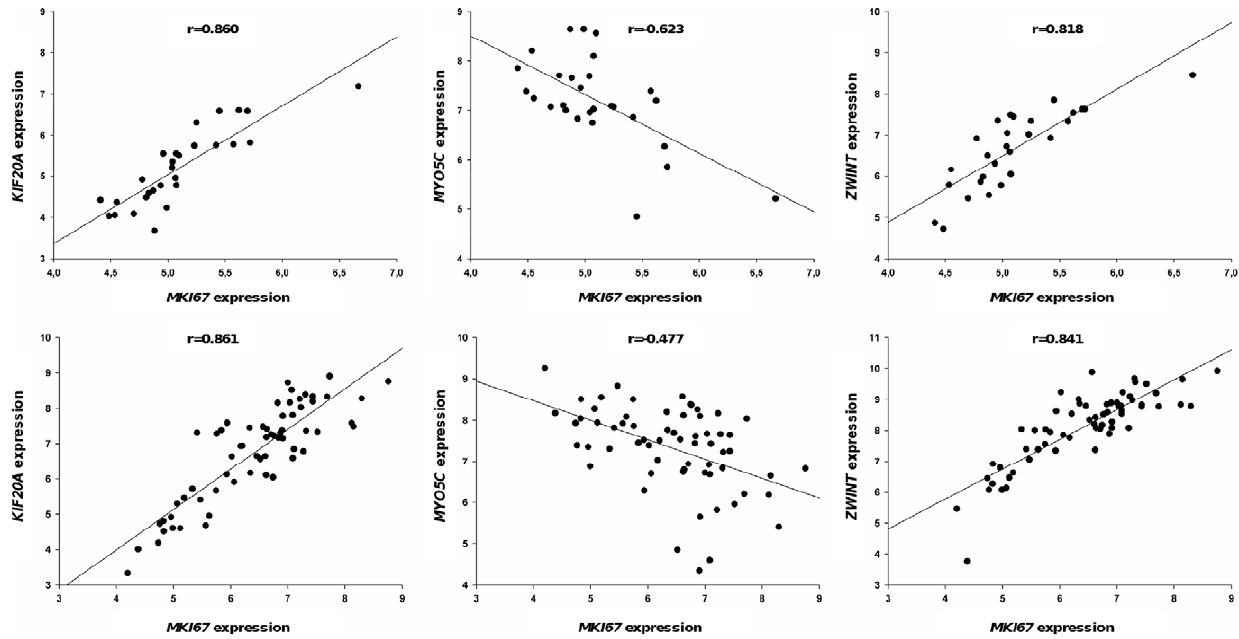
Figure 8. Several deregulated genes have their expression correlated with the expression of MKI67 , a proliferation marker gene. The Pearson correlation coefficient (r) between the expression of the deregulated genes and the expression of proliferation marker gene, MKI67 , was calculated for FGFR3 -mutated tumors in the TaG1G2 group (n=28) and for FGFR3 -non-mutated tumors in the T2–4 group (n=63). The expression of the deregulated genes as a function of MKI67 expression is shown in TaG1G2 FGFR3 -mutated tumors (upper figures) and in T2–4 non-mutated tumors (lower figures). Only the plots for the correlated genes are presented (p , 1%, which corresponds to a correlation coefficient, |r| above 0.479 for the FGFR3 -mutated tumor group and above 0.323 for the FGFR3 -non-mutated tumor group).